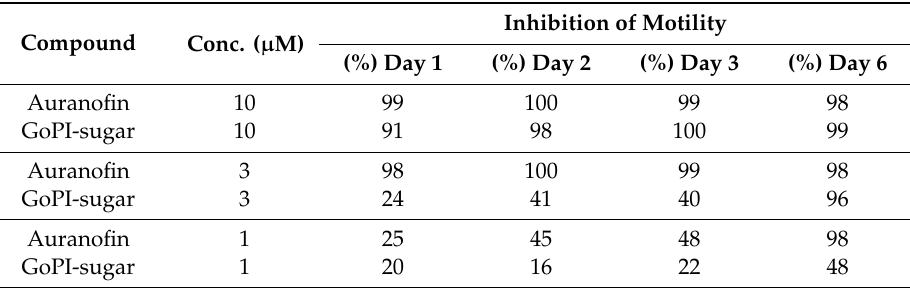
Table 3. Comparison of the worm killing activity of auranofin and GoPI-sugar with female B . pahangi worms in an in vitro motility assay [55]. Percent inhibitions are the average of n = 4 worms per concentration compared to vehicle treated